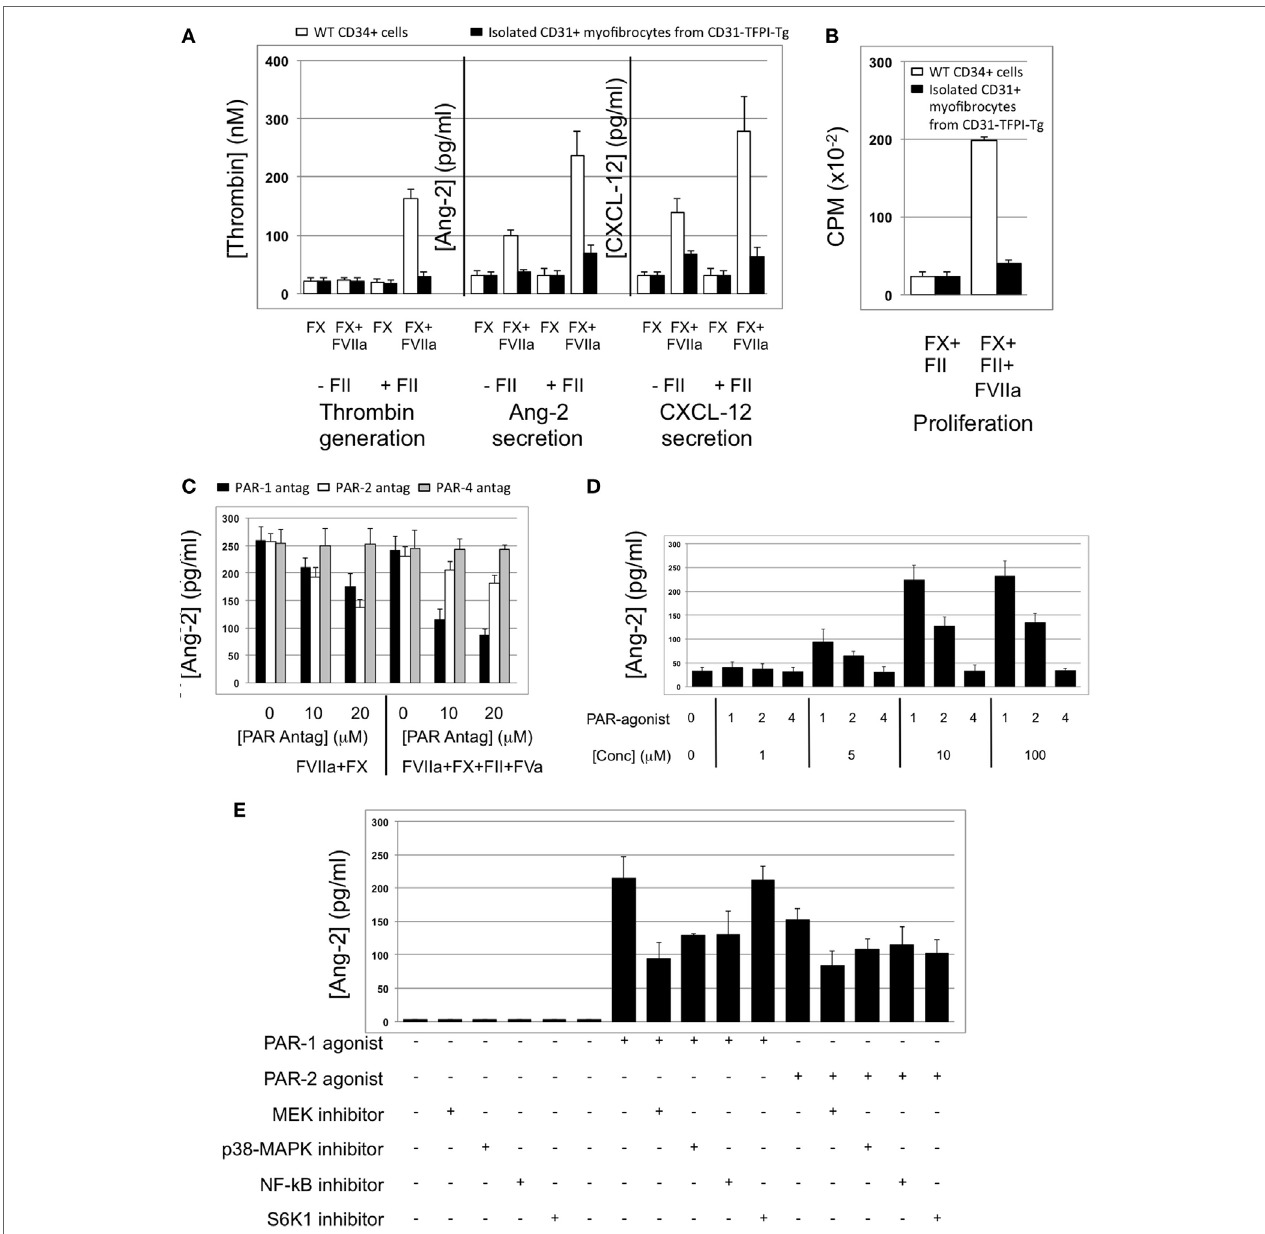
FigUre 6 | Impact of coagulation proteases on myofibrocyte phenotype. In (a,B) , responses of wild-type (WT) CD34 + cells are shown as white bars, whereas isolated CD31 + myofibrocytes from CD31-TFPI-Tg mice are shown as black bars. (a) Cells were incubated with FX in presence or absence of FVIIa and FII (prothrombin) plus FVa. Functional tissue factor on WT cells is illustrated by thrombin generation, angiopoietin-2 (Ang-2) secretion, and CXCL-12 secretion. The presence of human tissue factor pathway inhibitor on purified CD31 + myofibrocytes from CD31-TFPI-Tg mice significantly inhibits all three phenotype changes. (B) Proliferation, assessed by 3 H-thymidine incorporation and expressed as counts per minute (CPM) after incubation with FX and FII in presence of FVIIa. (c) Angiopoietin-2 secretion by WT CD34 + cells (3 × 10 4 /well) after 24 h incubation with either PAR-1 antagonist (black bars), PAR-2 antagonist (white bars), or PAR-4 antagonist (gray bars) at the indicated concentrations for 30 min before addition of FVIIa with FX (both 10 nM) with or without prothrombin (4 nM) and FVa (6 nM) as indicated. All conditions performed in triplicate wells. Error bars indicate SEM. In comparison of increasing concentrations of antagonists with FVIIa + FX, p = 0.027 for PAR2, but p = NS for PAR1 and PAR4. In comparison of increasing concentrations of antagonists with FVIIa + FX + FII + FVa, p = 0.05 for PAR1, but p = not significant (NS) for PAR2 and PAR4. Analysis by one-way ANOVA Kruskal–Wallis test. (D) Angiopoietin-2 secretion by WT CD34 + cells (3 × 10 4 /well) after 24 h incubation with PAR-1, -2, or -4 agonists at the indicated concentrations. All conditions performed in triplicate wells. Error bars indicate SEM. p = 0.017 for comparisons of increasing concentrations of PAR1 agonist, p = 0.012 for PAR2, but p = NS for PAR4 agonist. Analysis by one-way ANOVA Kruskal–Wallis test. (e) Dissection of signaling pathways involved in angiopoietin-2 secretion by WT CD34 + cells induced by 24 h incubation with 10 mM PAR-1 or -2 agonists. Cells were incubated with the agonists with or without 50 mM mitogen-activated protein kinase inhibitor PD98059, 10 mM p38-MAPK inhibitor SB203580, 20 mM NF-kB inhibitor SN50, or 1 mM of the S6K1 inhibitor as indicated. All conditions performed in triplicate wells. Error bars indicate SEM. p = 0.05 for PAR-1 agonist without inhibitor vs. + PD98509 and vs. + SB203580. p = > 0.05 all other comparisons. Analysis by Mann–Whitney T test. All experiments repeated at least